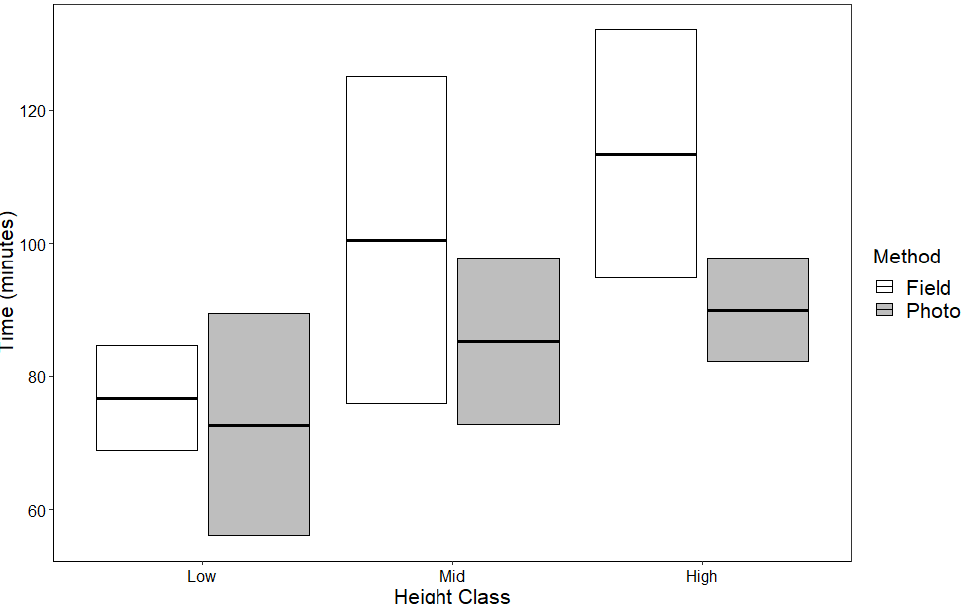
Figure 6. Survey time in minutes by survey method and vegetation height class. Height classes were low (<1 m), mid (1 m to 1.5 m), and high (>1.5 m). Crossbars represent the mean ± 95% confidence interval for 13 field plots within three vegetation height classes surveyed in 2019 by both the point- intercept and Photogrid methods. There were no significant effects of method, height class, or their interaction on survey time. The graph is provided to illustrate a trend that the photo method time was lower in mid and high height classes.